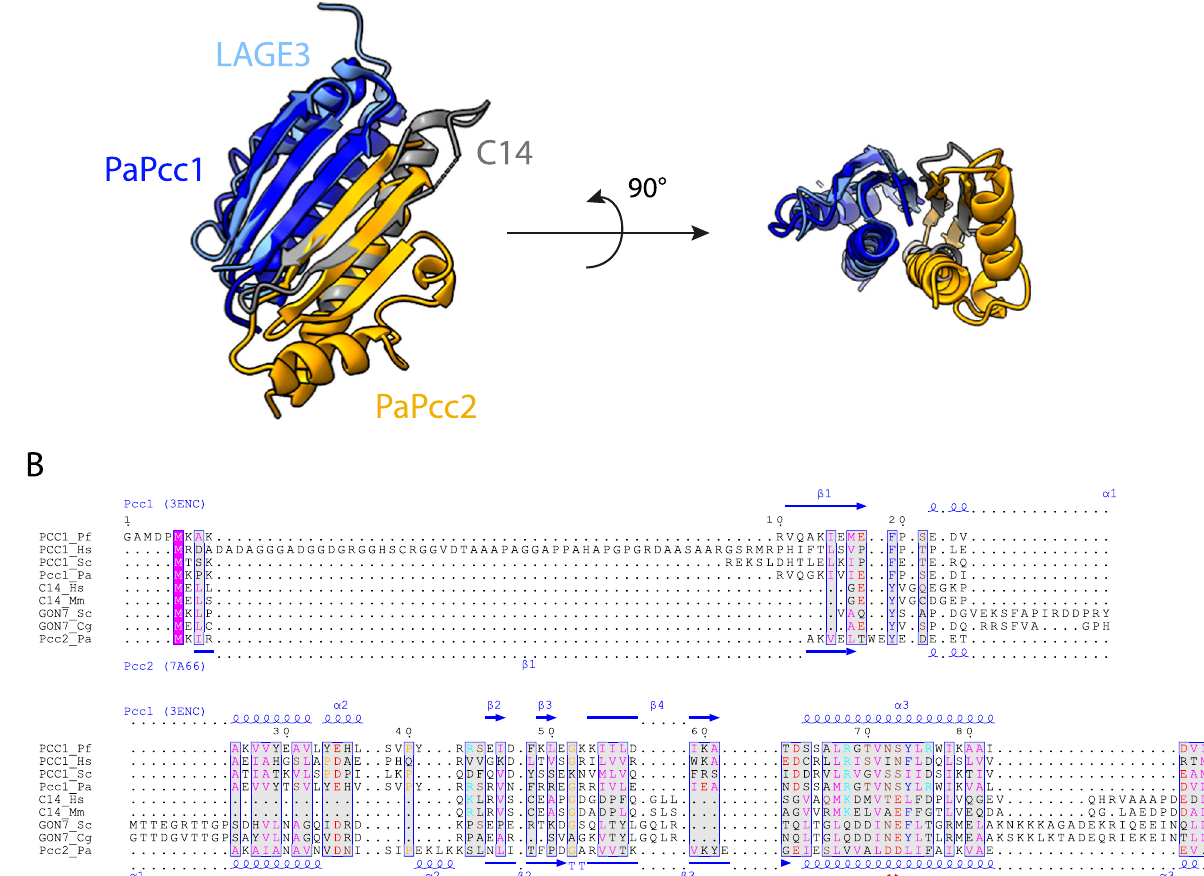
Fig. 8 | Sequence and structural comparison of Pcc2 and Gon7/C14 proteins. A Structural comparison of PaPcc1-PaPcc2 and human LAGE3-C14 heterodimers. Superimposition of the crystallographic PaPcc1-PaPcc2 structures (in blue and orange, respectively) on LAGE3-C14 (in light blue and grey, respectively). The left partisatopviewshowingthecontinuous5-strandand6-strand β antiparallelsheets stabilisingthetwointerfacesinLAGE3-C14andPaPcc1-PaPcc2complexes.Theright part is a side view showing the α helices that also contribute to the building of the interfaces. B Multiple sequence alignment of Pcc1, Pcc2, C14 and Gon7 proteins from representative metazoan ( H. sapiens , M. musculus ), fungal ( S. cerevisiae ,